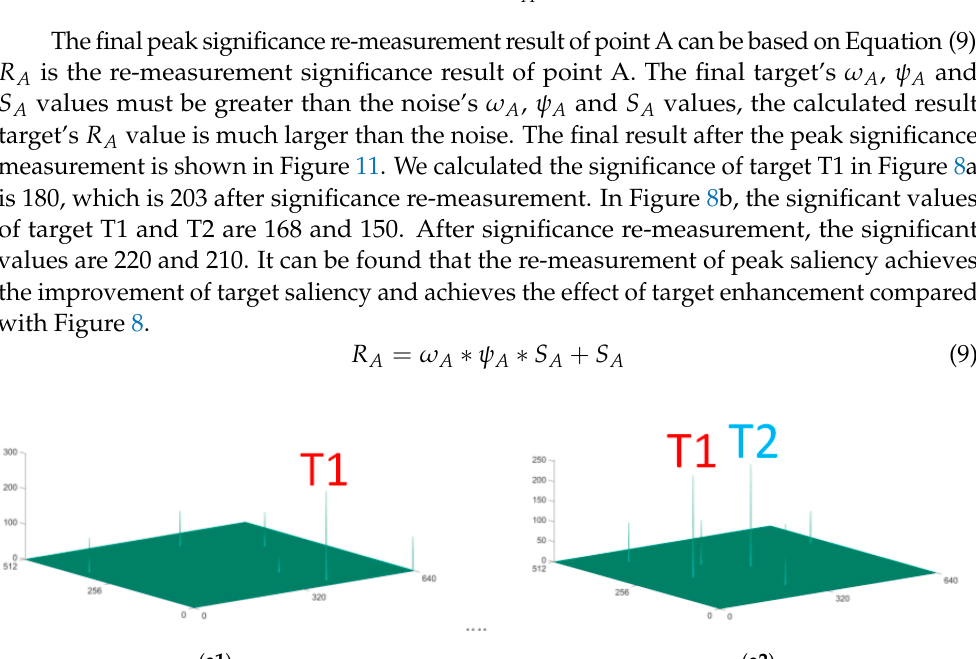
Figure 11. Peak significance re-measurement results of images A and B (Algorithm 3). ( a1 ) Re- measurement three dim result of image A. ( a2 ) Re-measurement three dim result of image B.